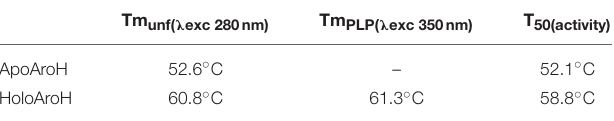
TABLE 2 | Half-temperatures of apo- and holoAroH unfolding.